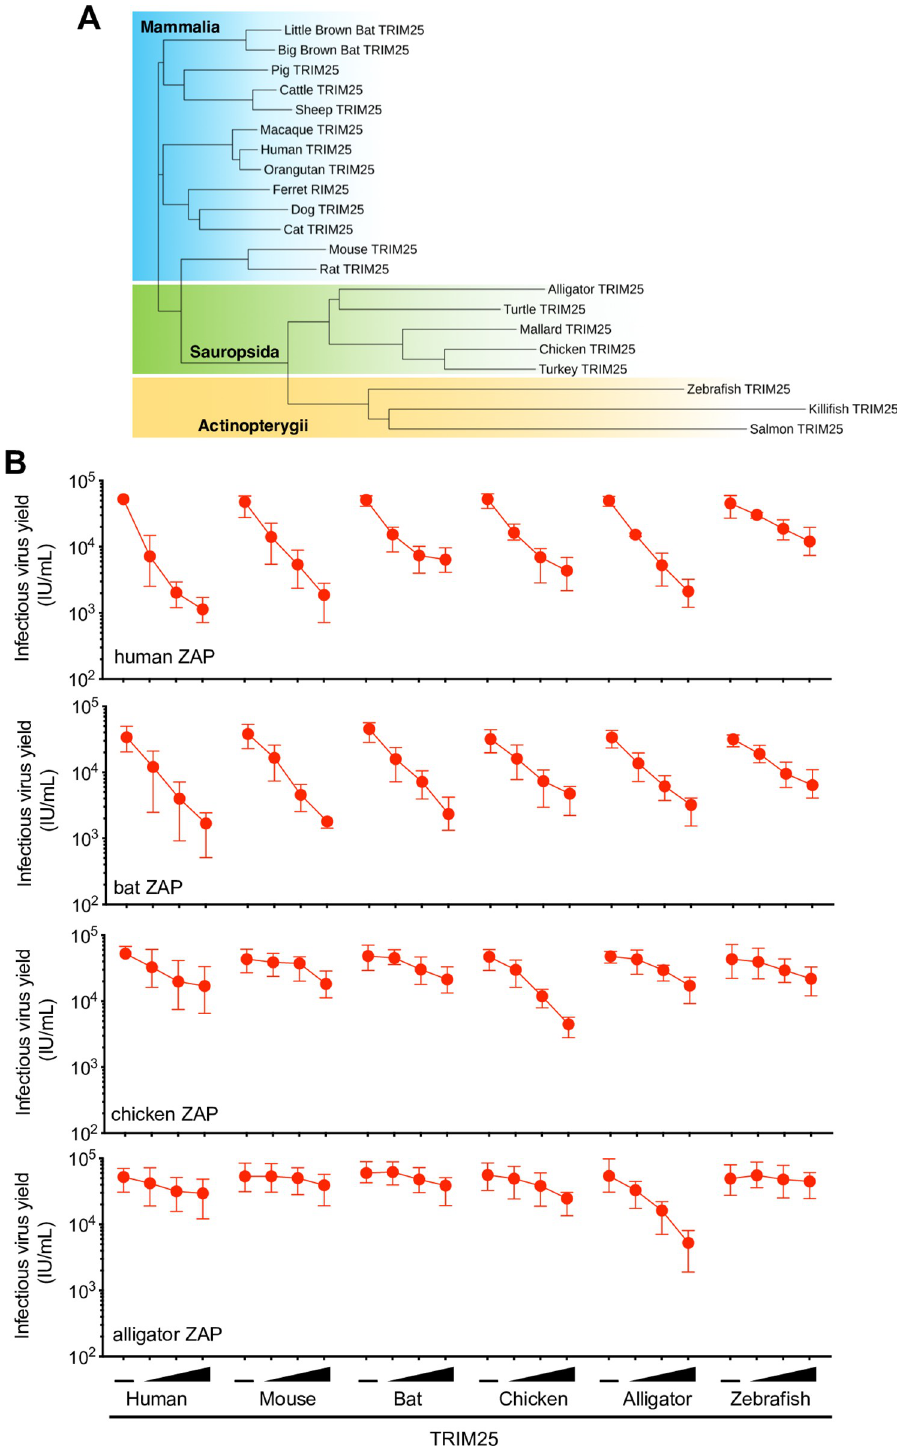
Fig 6. ZAP proteins from tetrapods have antiviral activity in the presence of cognate TRIM25. (A) Phylogenetic analysis of TRIM25 protein sequences from vertebrate species. Shaded areas indicate cluster sequences from mammals (in blue), birds and reptiles (in green) and ray-finned fish (in yellow). (B) HEK293T ZAP -/- and TRIM25 -/- cells were co-transfected with an